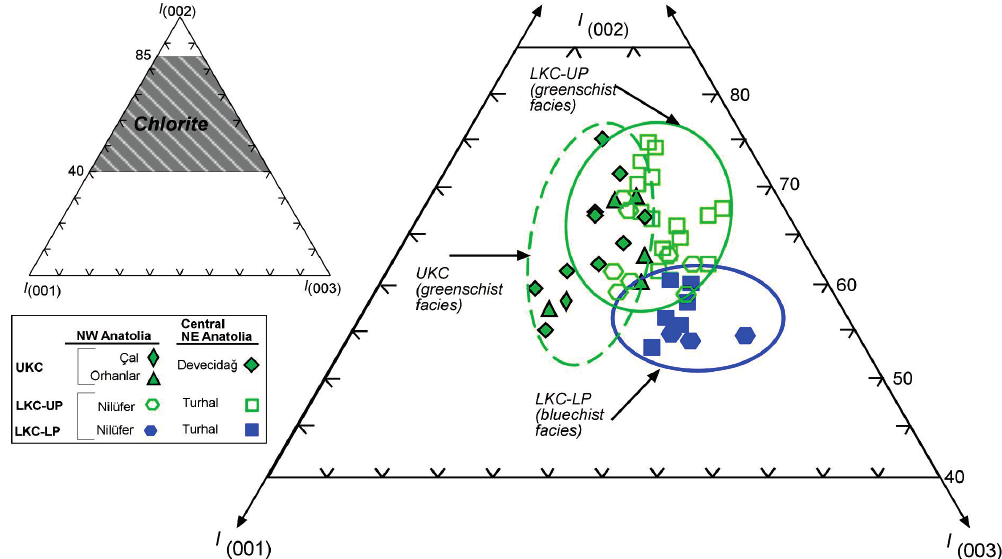
Figure 9. The distribution of chlorite minerals in the Karakaya Complex units in the triangular diagram according to the first three basal reflections (Chlorite area: Árkai and Ghabrial